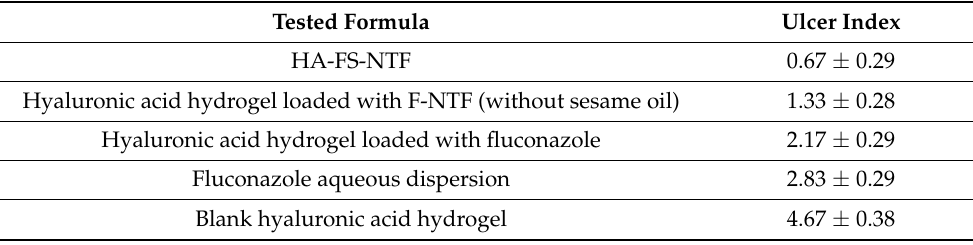
Table 10. In vivo ulcer index of the Candida albicans-infected immunocompromised animals after 3 days of